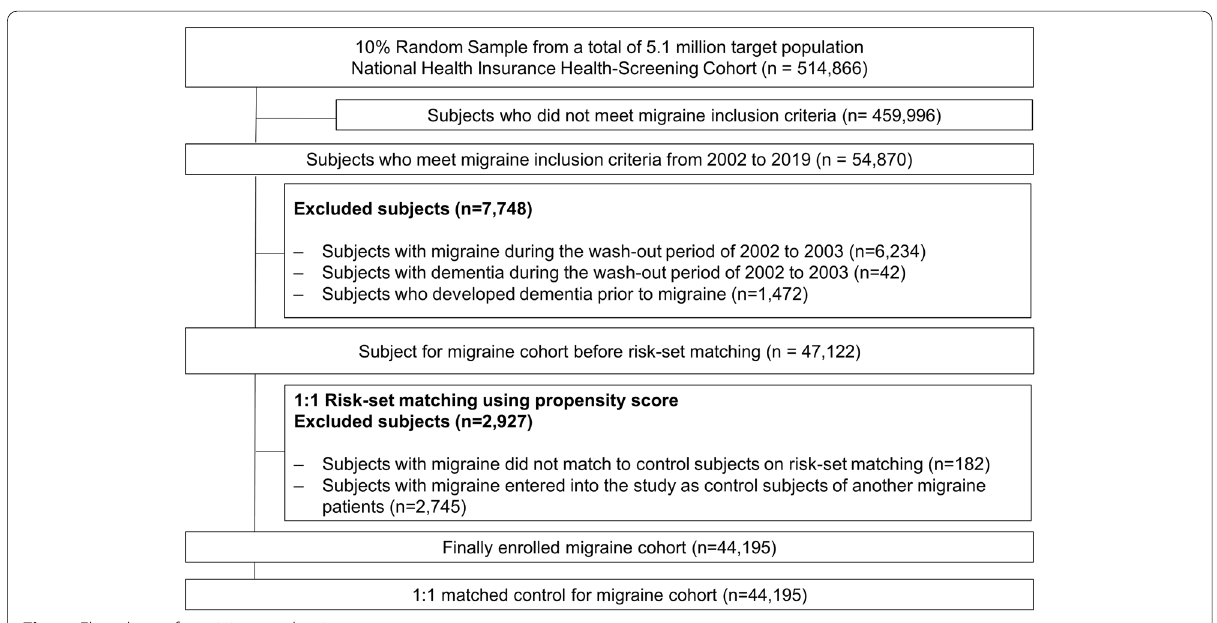
Fig. 1 Flowchart of participant